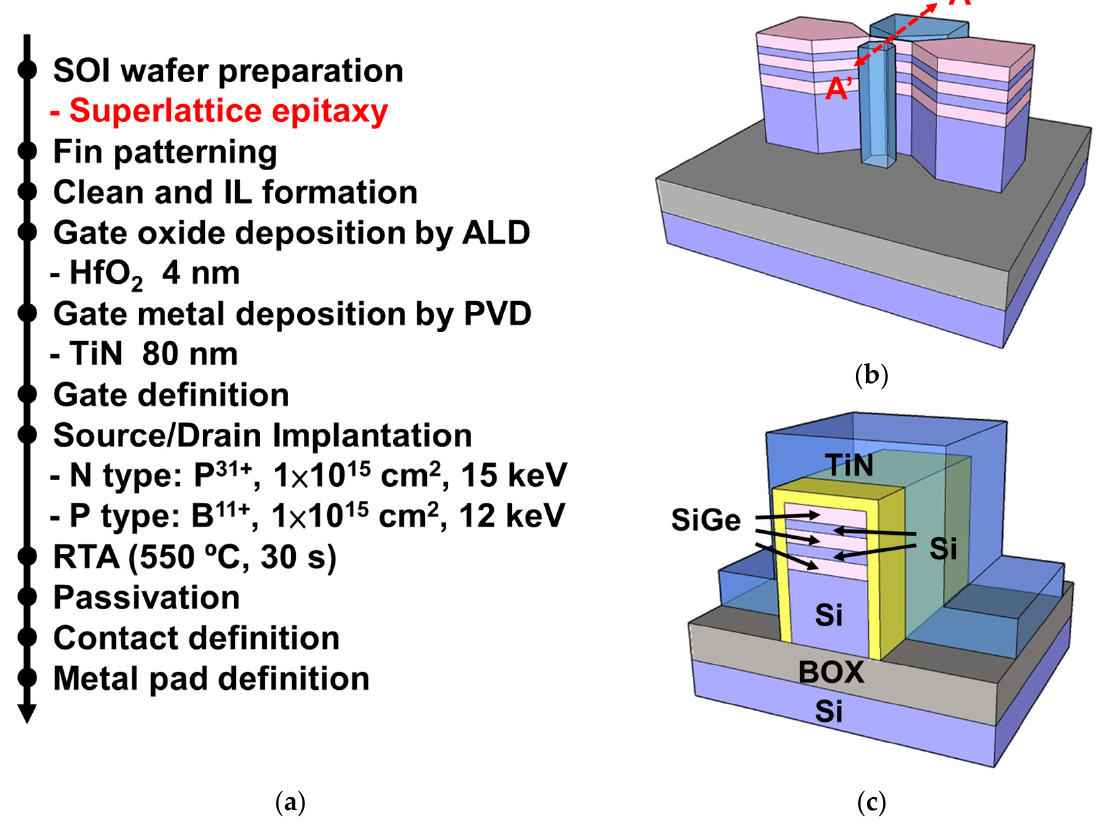
Figure 1. ( a ) Process flow for fabricating the Si 0.8 Ge 0.2 /Si SL FinFET. ( b ) Three-dimensional schematic and ( c ) A–A’ cross-sectional view of the Si 0.8 Ge 0.2 /Si SL FinFET.